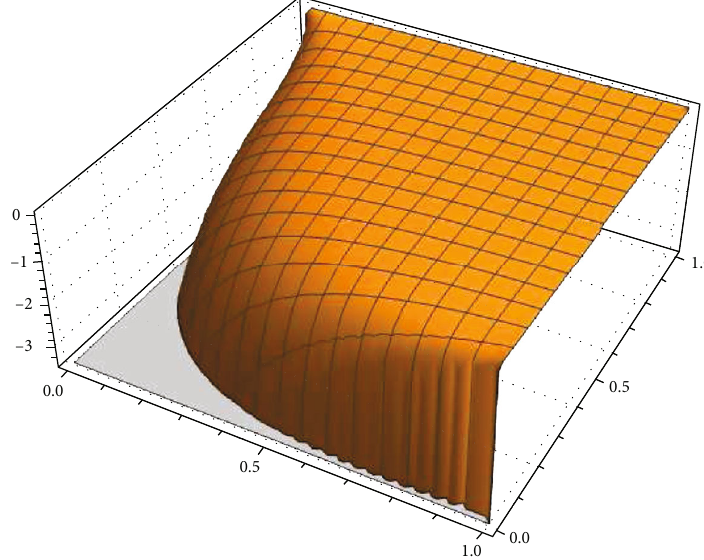
Figure 9: Mean curvature of the bilinear interpolation surface ruled